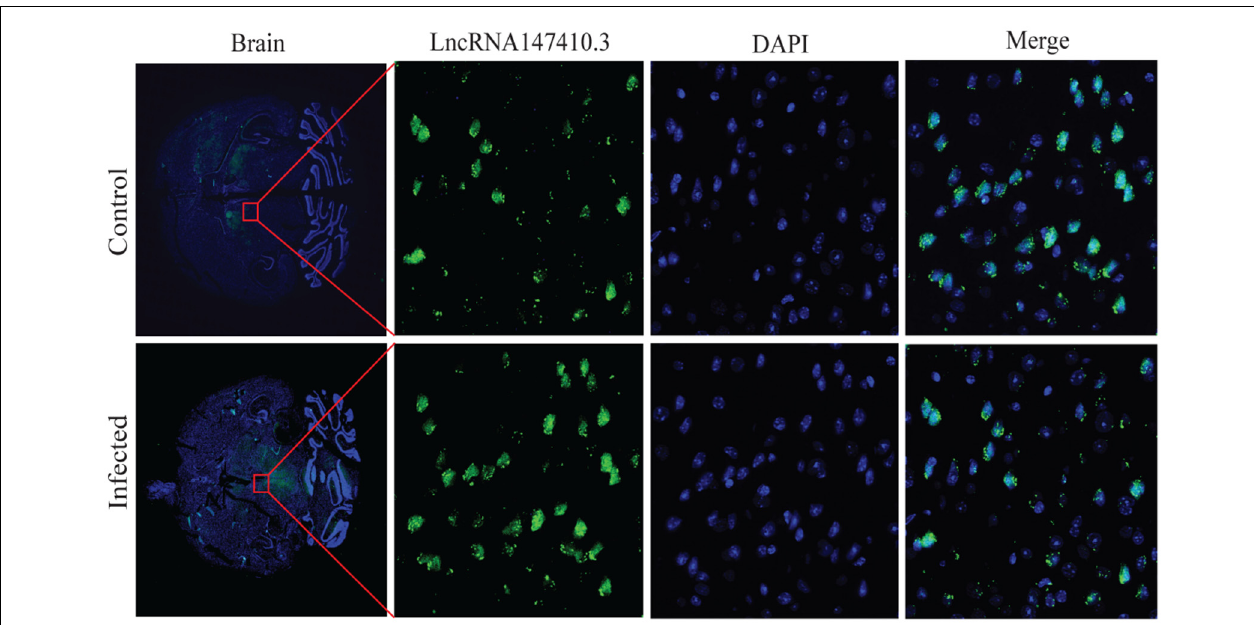
FIGURE 3 | Localization of lncRNA147410.3 expression in the mice brain infected with T. gondii . Fluorescence in situ hybridization (FISH) binding affinity of lncRNA147410.3 shows a significant downregulation trend in the brain of T. gondii infected mice compared with that of the uninfected mice.